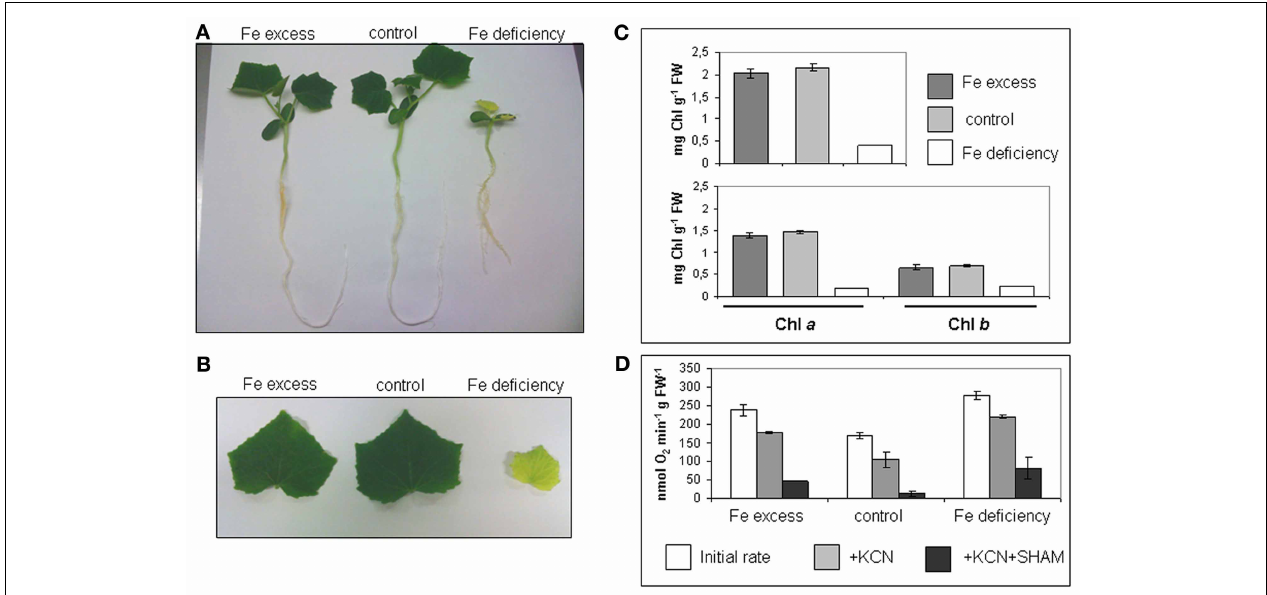
FIGURE 1 | Cucumber seedlings under different conditions of Fe supply. (A) 10 days-old cucumber seedlings grown in hydroponic medium containing either 500 µ M Fe(III)-EDTA (Fe excess), 50 µ M Fe(III)-EDTA (control), or with no added Fe in the medium (Fe deficiency). (B) Leaves of cucumber seedlings grown as in (A) . (C) Chl content (mg g − 1 FW) of seedlings leaves, grown as in (A) ; upper panel: total Chl content; lower